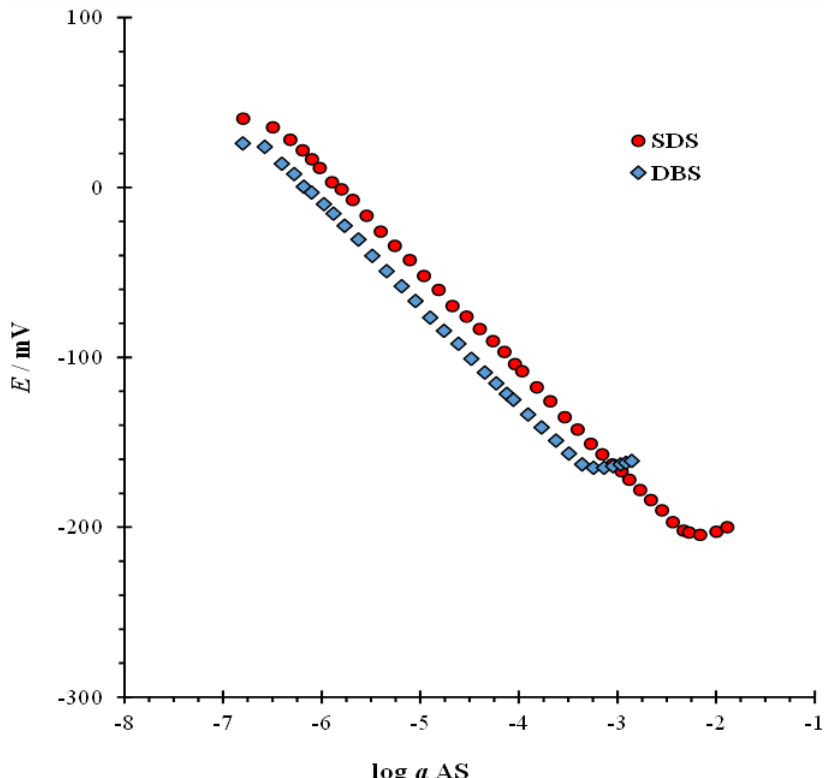
Figure 2. Direct potentiometric response characteristics of DODI–TPB surfactant sensor to anionic surfactants SDS and DBS in H 2 O at a wide concentration range, with mean values at ± 95% confi- dence limits. Table 2. Response characteristics of DODI – TPB surfactant sensor to anionic surfactants DBS and SDS in H 2 O, given together with ± 95% confidence limits.